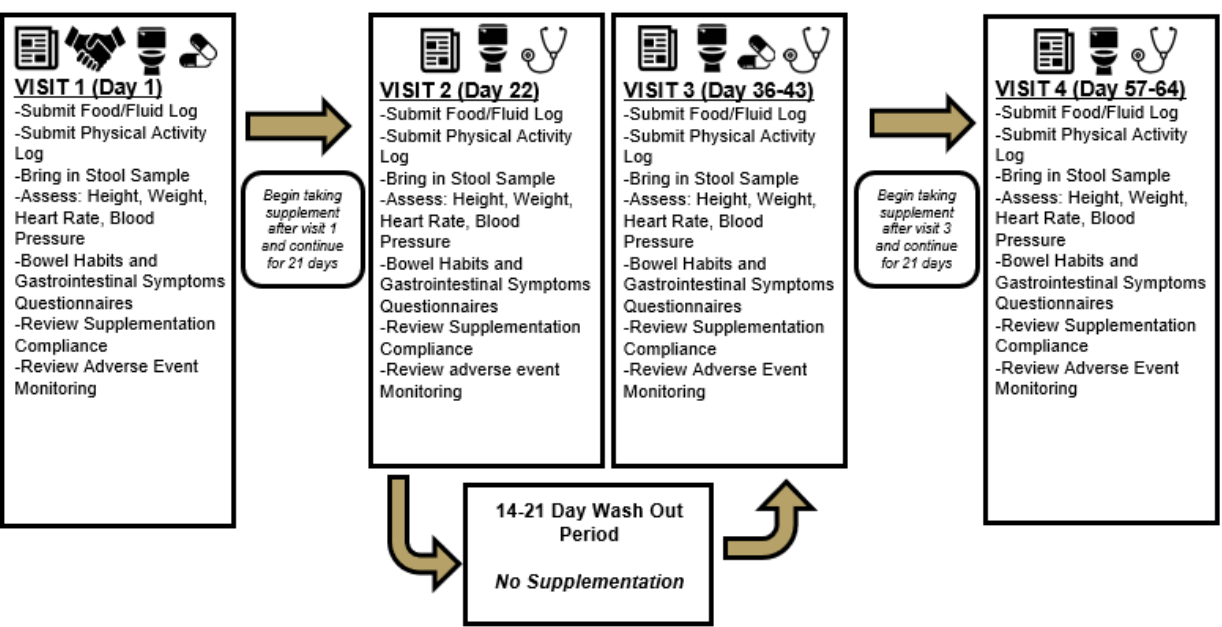
Figure 1. Flow chart of experimental design.